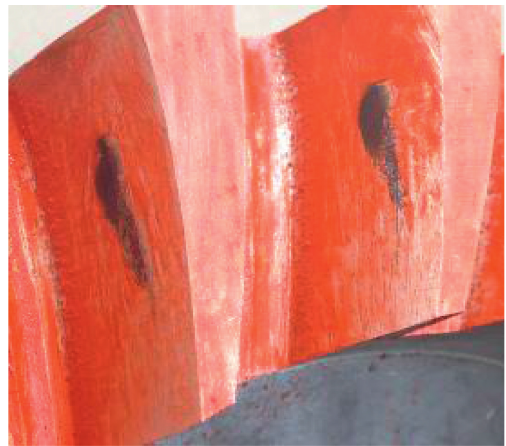
Figure 13: Contact area of the concave tooth surface.